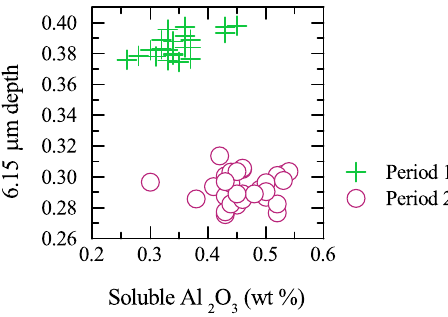
Figure 6. Depth of the δ H 2 O feature at 6.15µm compared with the soluble Al 2 O 3 content, highlighting the differences between samples collected in the first and second periods.